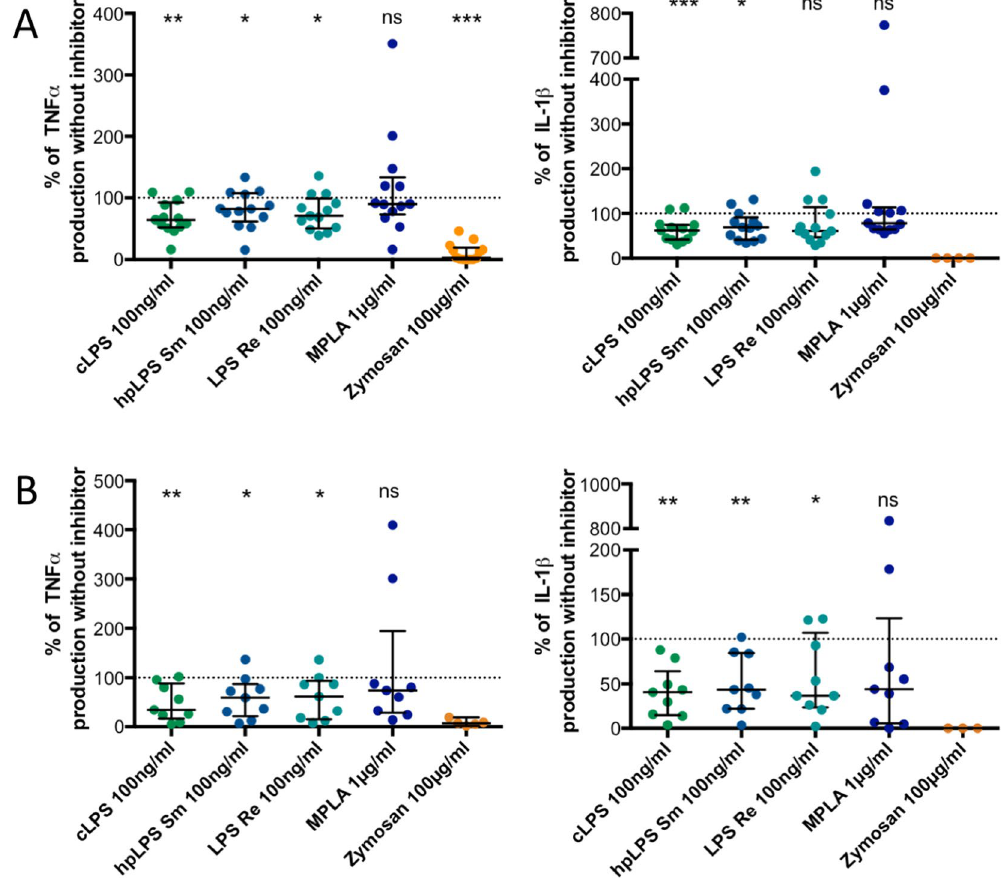
Figure 9. Effect of Syk inhibitor R406 ( A ) 1 µ M, or ( B ) 5 µ M on TNF and IL-1 β production by human adherent mononuclear cells activated by either conventional smooth E. coli O111:B4 LPS (cLPS) (100 ng/ml), highly purified S. abortus equi LPS (hpLPS) (100 ng/ml), highly purified rough S. minnesota LPS (ReLPS) (100 ng/ ml), MPLA (1 µ g/ml) or zymosan depleted (100 µ g/ml) for different donors. R406 did not affect the cytokine production in the absence of agonists (data not shown). Each dot represents one individual donor. Results are expressed as percent of the individual responses in the absence of inhibitor. * p ≤ 0.5; ** p < 0.01; **** p < 0.001; *** p <